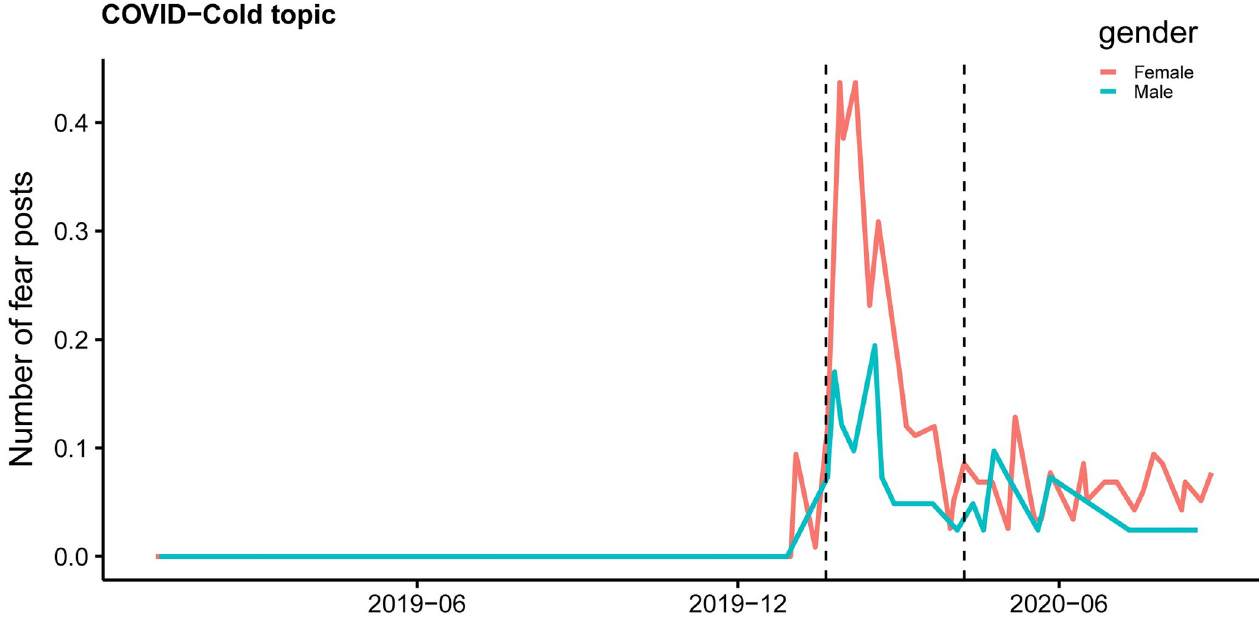
Fig 6. Number of COVID-19 related fear posts (cold topic) by gender. Line graphs show the average number of fear posts generated by every 1,000 users in each gender by week (Female: Solid line above, Male: Solid line below).